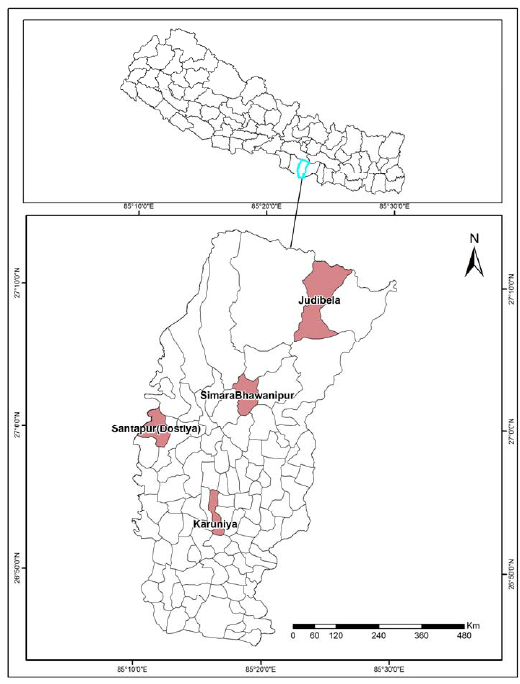
Figure 1. Location map of the study area within the map of Nepal.